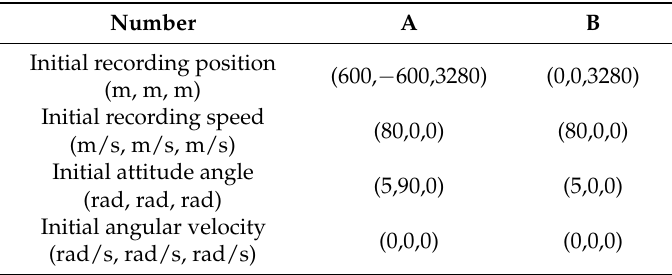
Table 5. Initial Table 5. Initial state. Table 5. Initial state.